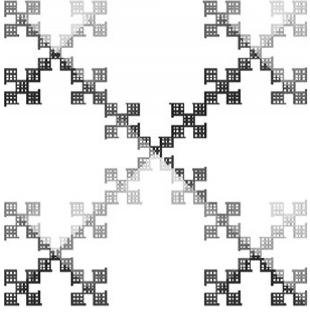
Fig. 1 Fractal image illustration art design of standard algorithm.